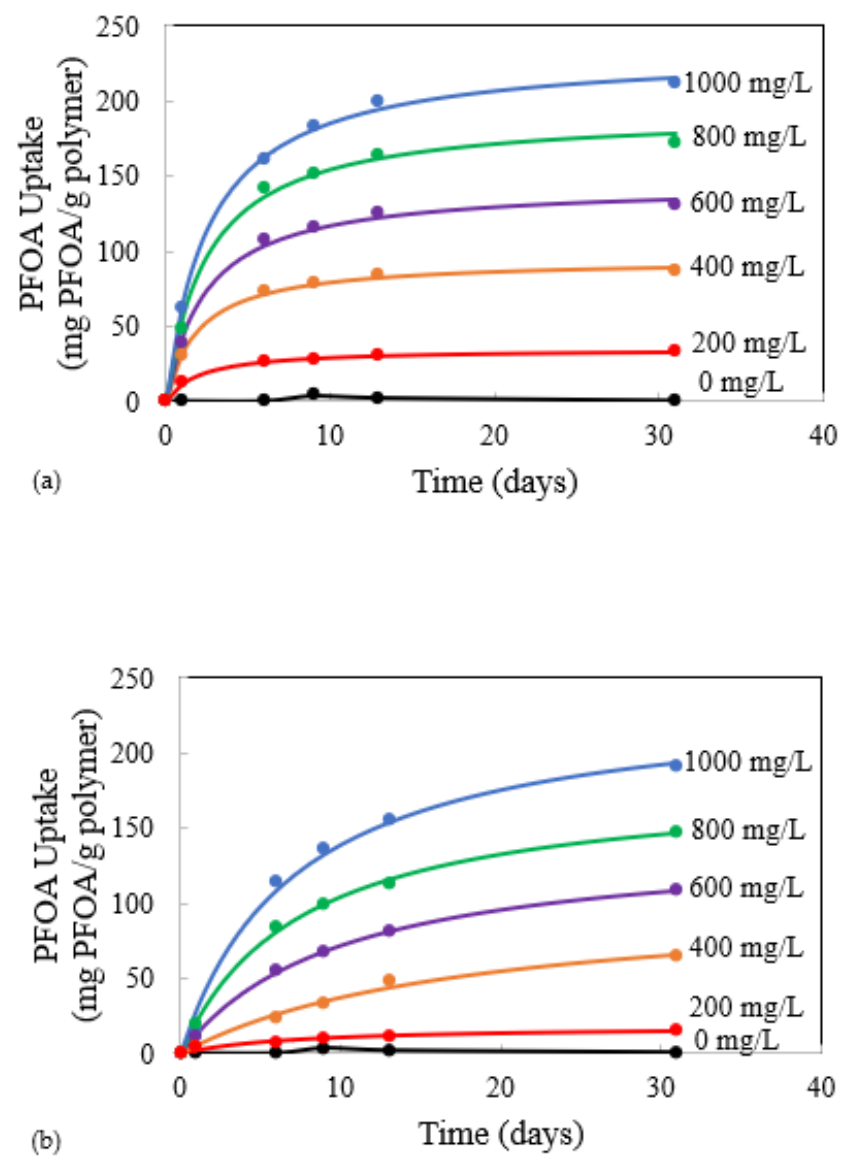
Figure 6. Kinetic modeling of PFOA uptake onto ( a ) 0.10 ZnO-PDMS and ( b ) 0.10 CuO-PDMS membrane samples. The values by each line represent the initial PFOA concentrations (mg/L). Membrane samples were initially 0.1 g and 1 mm in thickness. Table 4. Summary of kinetic model parameters for the uptake of PFOA on 0.10 ZnO-PDMS and CuO-PDMS as a function of initial PFOA concentration in deionized